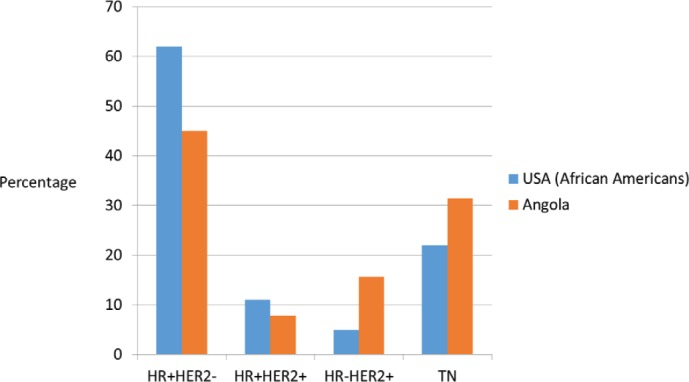
Distribution of breast cancer phenotype in United States African–American population [27] and Angola population (our study).